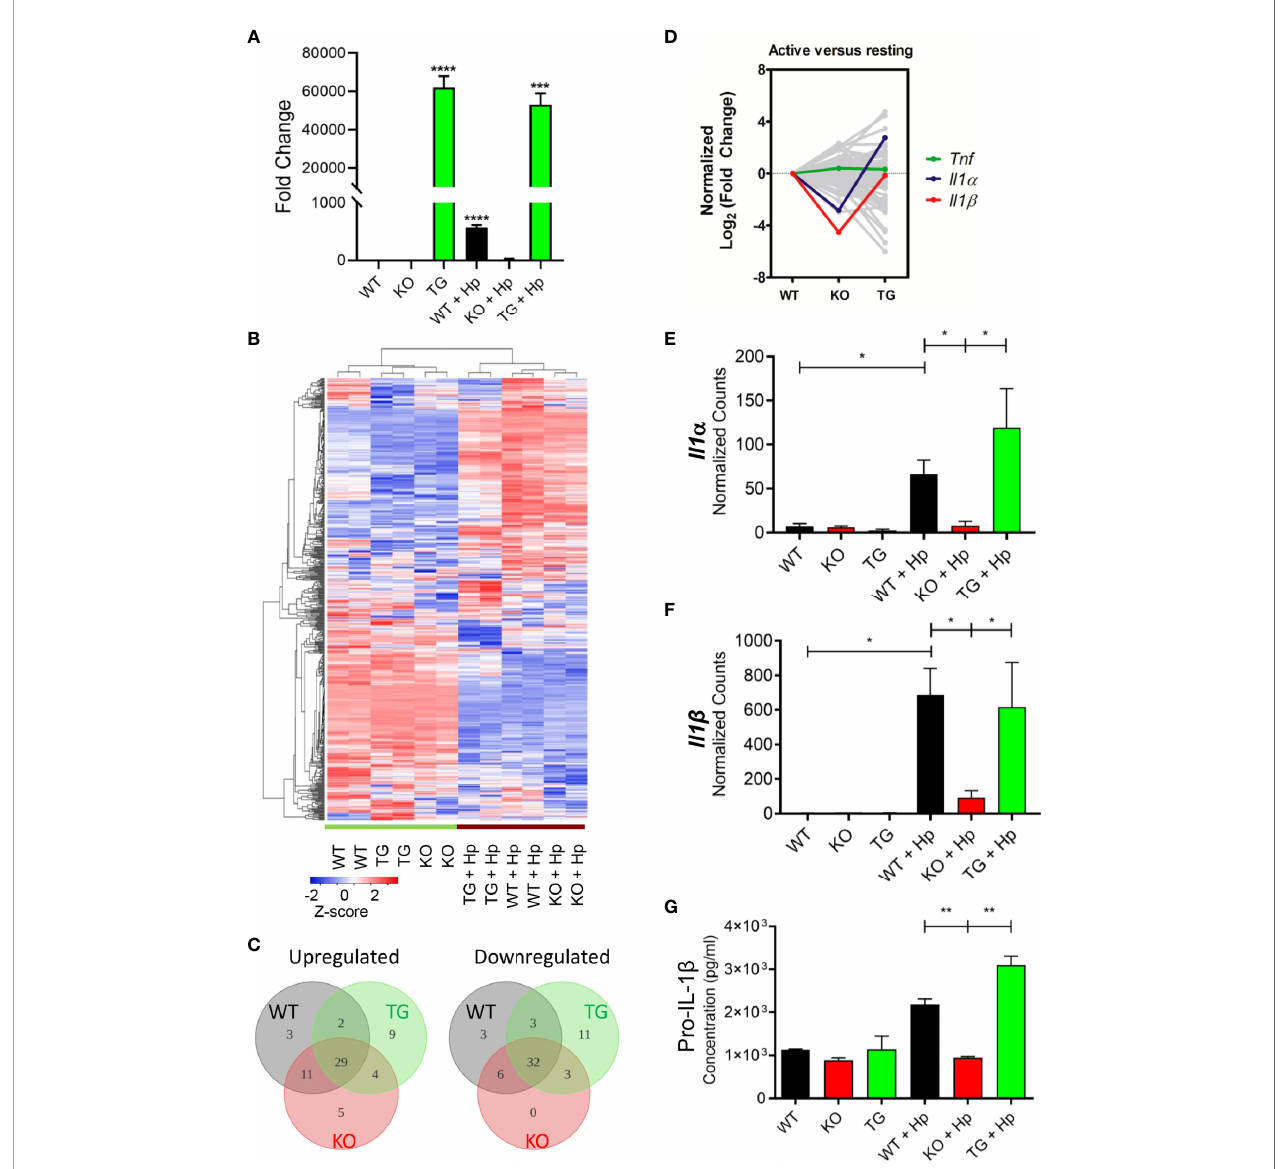
FIGURE 4 | Pdpn -deletion inhibits the production of IL-1 b proin fl ammatory cytokine. (A) Bar chart depicting the fold changes of Pdpn mRNA transcript expression in the wild type (WT), Pdpn -knockout (KO), and Pdpn -transgenic (TG) cells, before and after H. pylori infection at MOI 10 for 24 h (as indicated by +Hp). The mRNA transcript was isolated from each cell, reverse transcribed to cDNA and subjected to quantitative RT-PCR analysis. y- axis shows normalized fold change of Pdpn over b - actin internal control. Data were shown as mean ± SD of triplicates obtained from representative of two independent experiments. Statistical signi fi cance was analyzed with unpaired Student ’ s t -test ( ***p < 0.001, ****p < 0.0001). (B) Heatmap showing the gene expression and hierarchical cluster analysis of NanoString data. Color intensity re fl ects the Z -scores of the RNA abundance. Red represents upregulation while blue represents downregulation. All samples were run as biological duplicates. Statistical analysis was performed by R-based statistic program by either loglinear regression or simpli fi ed negative binomial model and adjusted with the Benjamini – Yekutieli method in nCounter Advanced Analysis 2.0 software. (C) Venn diagrams show the number of differentially upregulated (log 2 fold change > 2, left panel) or downregulated (log 2 fold change < -2, right panel) genes following H. pylori infection. Subsets are WT (gray), KO (red), and TG (green). Overlap region indicated the number of common differentially expressed genes among comparison groups. Diagram was generated by Lucidchart platform. (D) Line chart showing the normalized trend of differentially expressed genes following infection. y- axis represents the normalized log 2 fold change of each gene in WT, KO, or TG samples over the log 2 fold change of WT. Sharp “ V ” trendline was observed for Il1 a and Il1 b in KO cells, indicating drastically lower increment following infection when compared to both WT and TG cells. Differential expressions were computed in the nSolver Advance Analysis Software 2.0. (E, F) Bar charts show normalized RNA transcript counts of (E) Il1 a and (F) l1 b from NanoString analysis. Data are shown as mean ± SD of duplicate samples. Statistical signi fi cance was analyzed with unpaired Student ’ s t -test ( *p ≤ 0.05). (G) Bar chart shows ELISA analysis of pro-IL-1 b production in cell lysate. y- axis represents cytokine concentrations in pg/ ml. Data were shown as mean ± SD of duplicates obtained from representative of two independent experiments. Statistical signi fi cance by unpaired Student ’ s t -test ( **p <